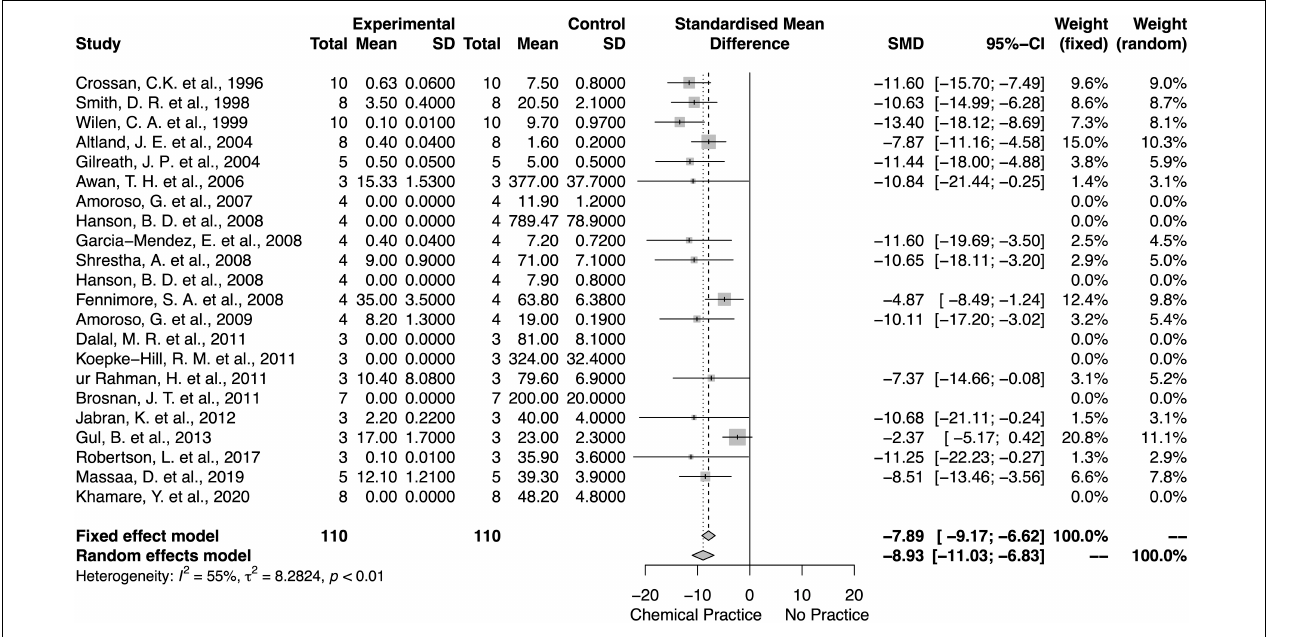
FIGURE 7 | Meta-analysis for the chemical weed control method on weed density.